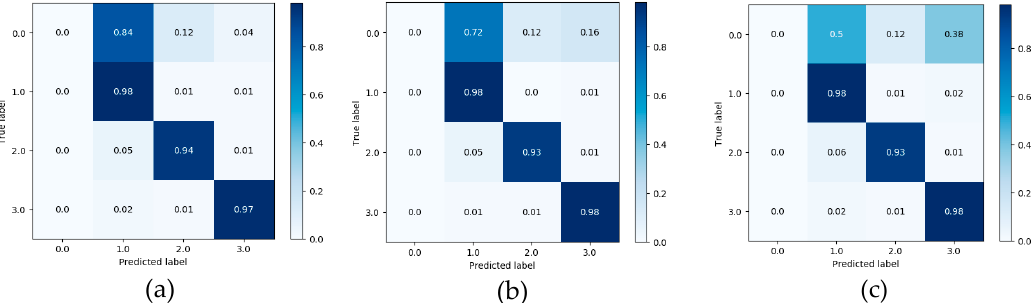
Figure 7. Confusion matrix obtained from LSTM classifier at three different paces: 0.78 m/s ( a ), 1.0 m/s ( b ) and 1.25 m/s class ( c ).